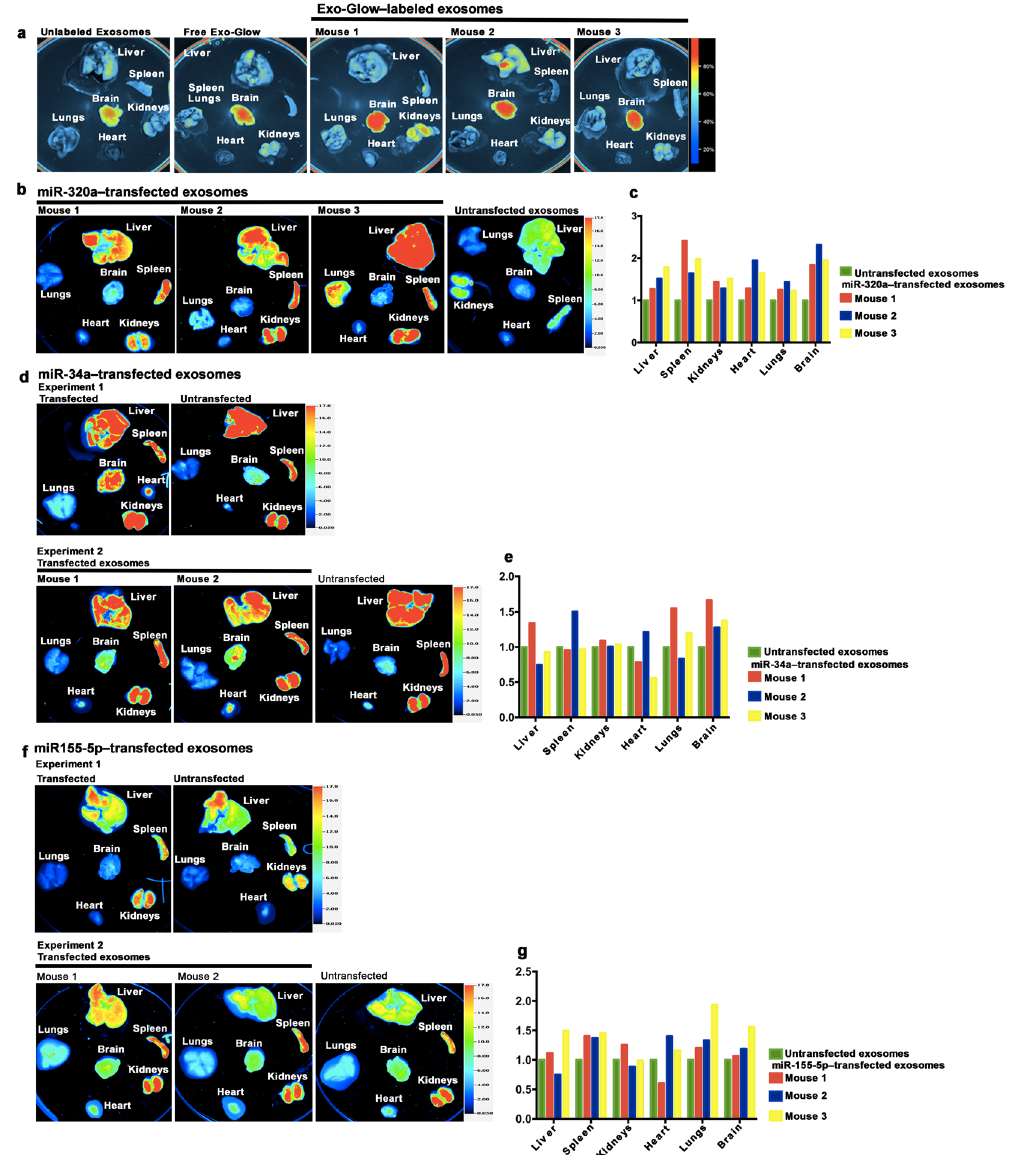
Figure 3. Bioavailability and distribution of fluorophore-labeled RNAs transfected into bovine milk exosomes and administered to mice. ( a ) Fluorescence signal from Exo-Glow-labeled RNA, delivered through oral gavage of bovine milk exosomes (1 × 10 12 /g body weight) in Balb/c mice 12 hours after administration. ( b ) Distribution of synthetic IRDye-labeled miR-320a, transfected into milk exosomes (1 × 10 12 /g body weight) 6 hours after delivery of exosomes by oral gavage in Balb/c mice. ( c ) Densitometry analysis of miR-320a distribution shown in panel b. ( d ) Distribution of synthetic IRDye-labeled miR-34a, transfected into milk exosomes (1 × 10 12 /g body weight) 6 hours after delivery of exosomes by oral gavage in Balb/c mice. Data from two experiments are shown. ( e ) Densitometry analysis of miR-34a distribution shown in panel d. ( f ) Distribution of synthetic IRDye- labeled miR-155-5p, transfected into milk exosomes (1 × 10 12 /g body weight) 6 hours after delivery of exosomes by oral gavage in Balb/c mice (n = 3). ( g ) Densitometry analysis of miR-155-5p distribution shown in panel f. Panels in this figure were assembled from multiple independent images; individual images in the grouped figure are separated by white